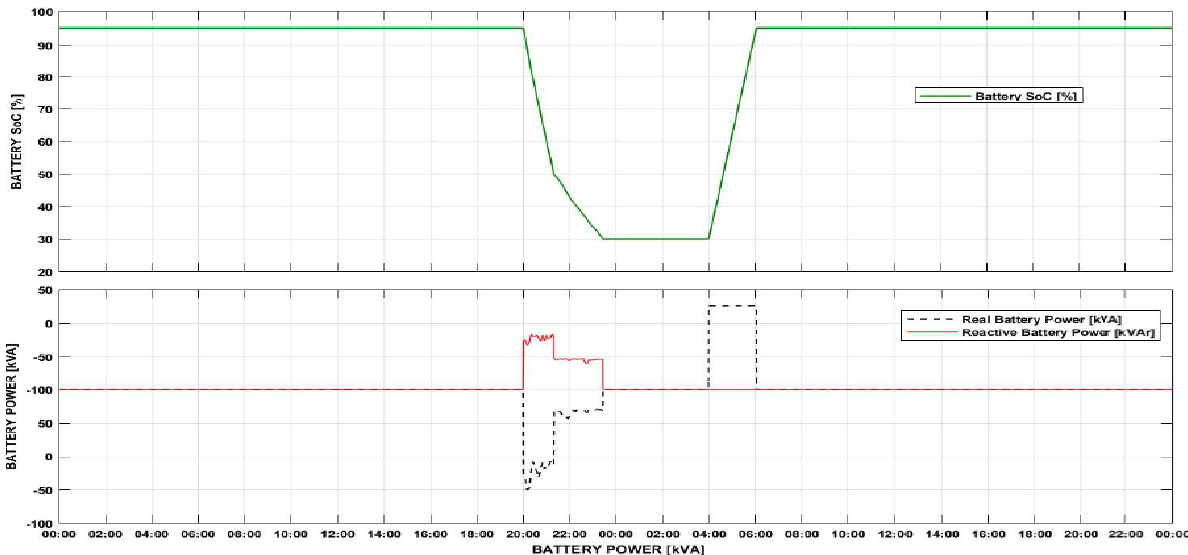
Figure 25. Performance of the optimum-sized energy storage during an 8-h power cut at 8 p.m.